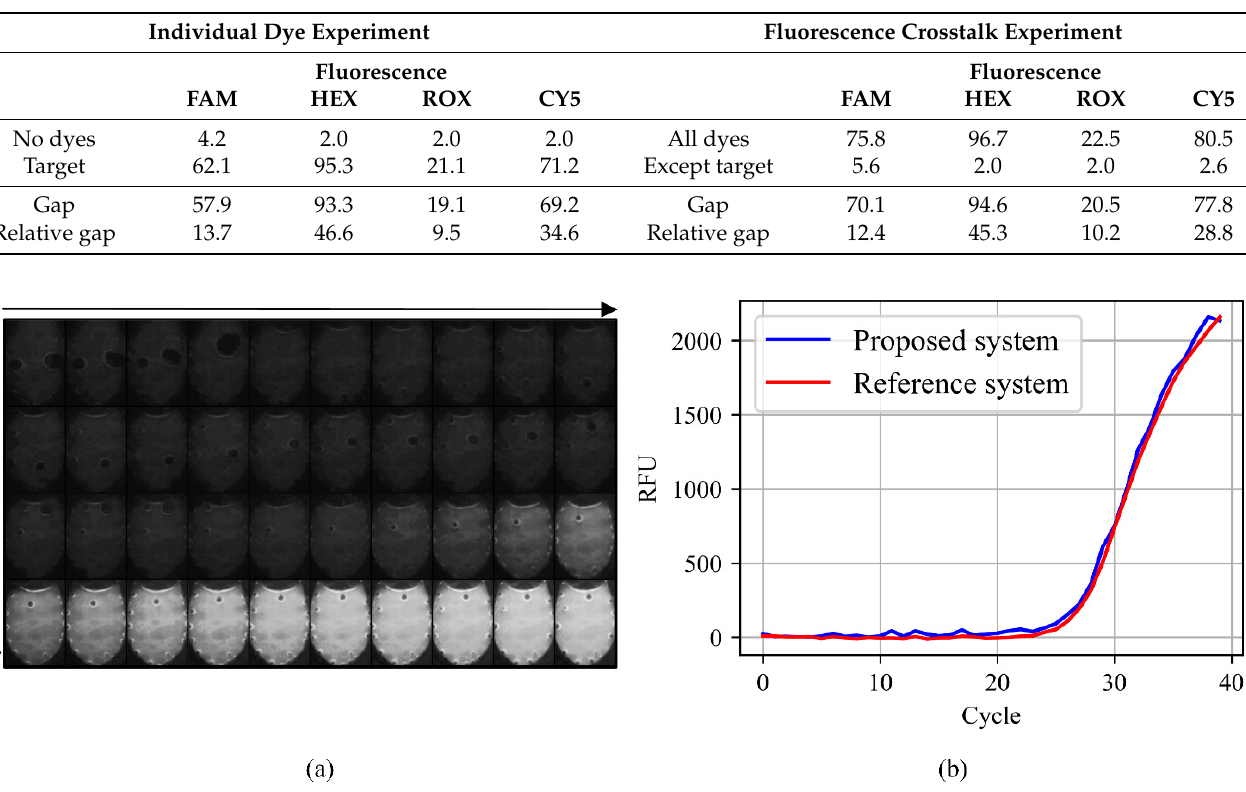
Figure 11. Cycle threshold obtained from the proposed system with a CMOS camera (blue) and reference system using a photodiode (red). 4. Discussion This research proposes a compact and cost-effective multiplex fluorescence detection system utilizing the PCB-based PCR chip previously reported from our group [46] . The portability and cost-effectiveness of the multiplex fluorescence detection system was dras- tically increased by employing an open platform CMOS camera and a compact emission